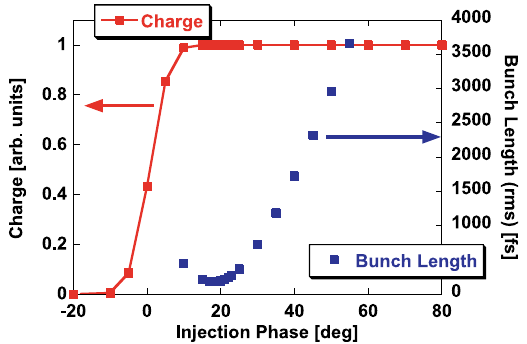
FIG. 10 (color online). Expected bunch length as a function of injection phase at z ¼ 3 . 0 m. The shortest bunch was 180 fs (rms) at the phase of 19°.